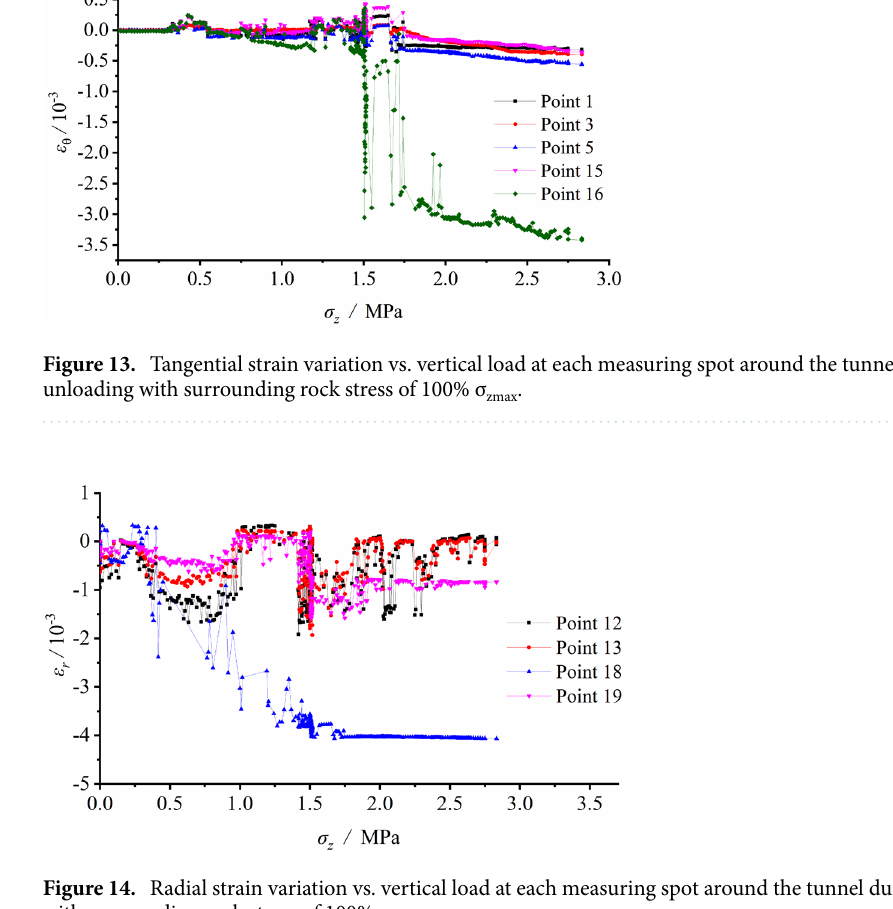
Figure 14. Radial strain variation vs. vertical load at each measuring spot around the tunnel during unloading with surrounding rock stress of 100% σ zmax